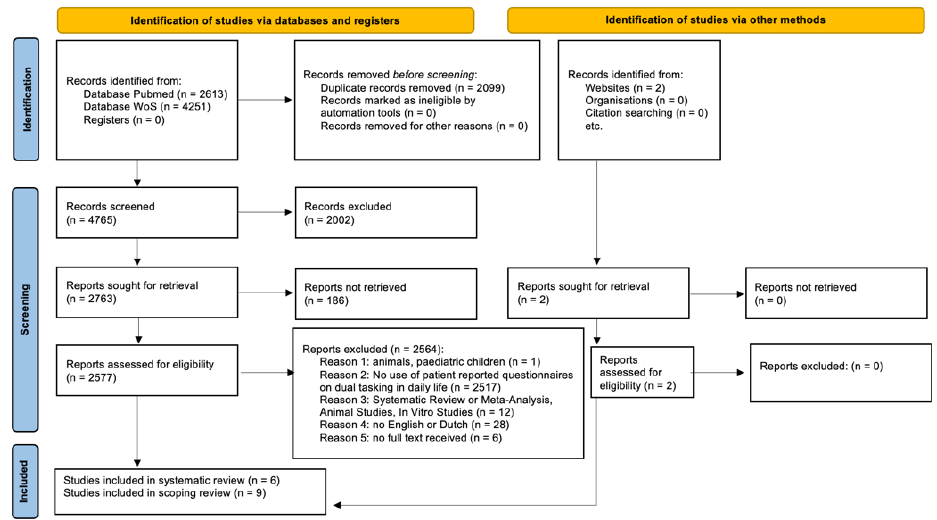
Figure 1. Flowchart of the study.